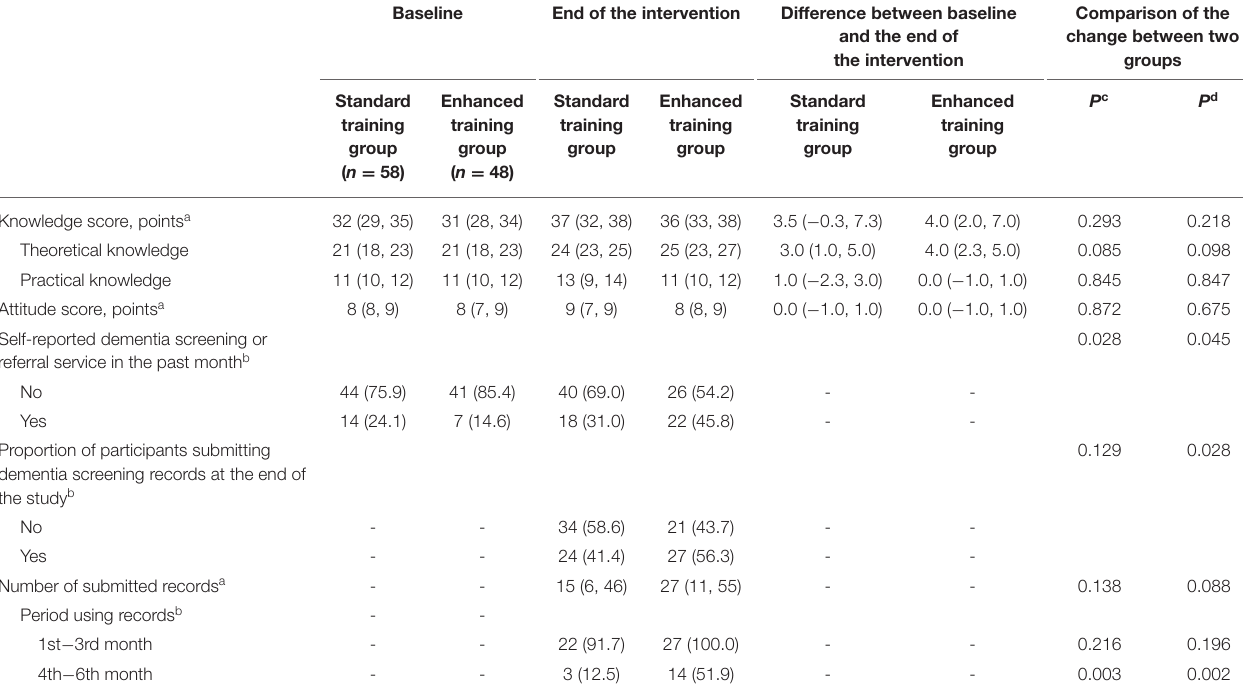
TABLE 2 | Changes in knowledge, attitudes, and provided service related to dementia detection from baseline to the end of the intervention.